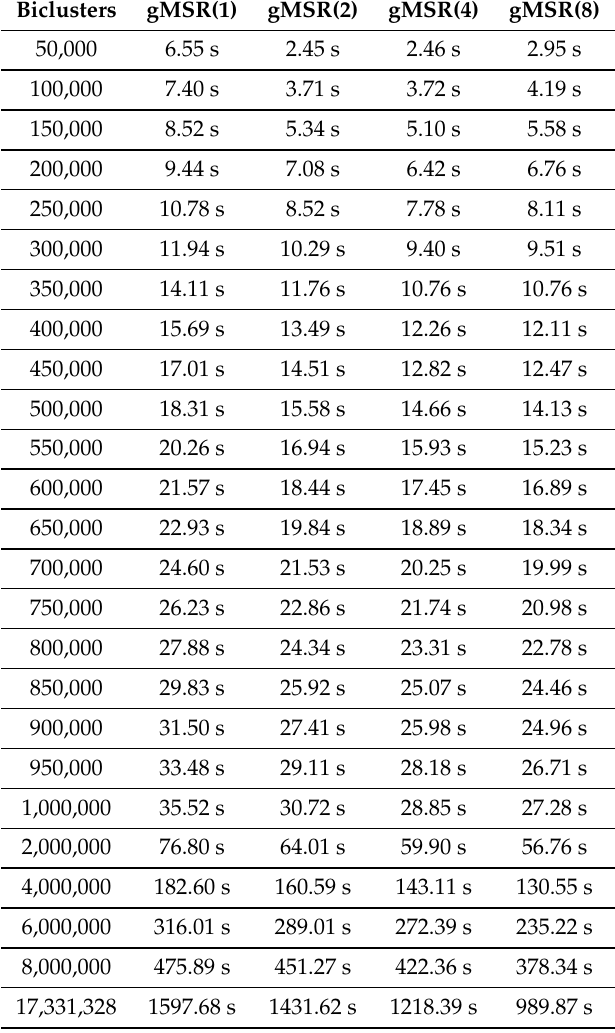
Table A3. This table shows the execution times in seconds for the real biclusters datasets. The first column represents to the number of biclusters generated by gBiBit, from 50,000 to 17,331,328. The other four columns represent the gMSR executions using 1, 2, 4 and 8 GPU devices, respectively. As it can be observed, multi-GPU mode improves runtimes as the volume of the bicluster dataset increases. Despite the large volume of data to be processed, gMSR execution times are